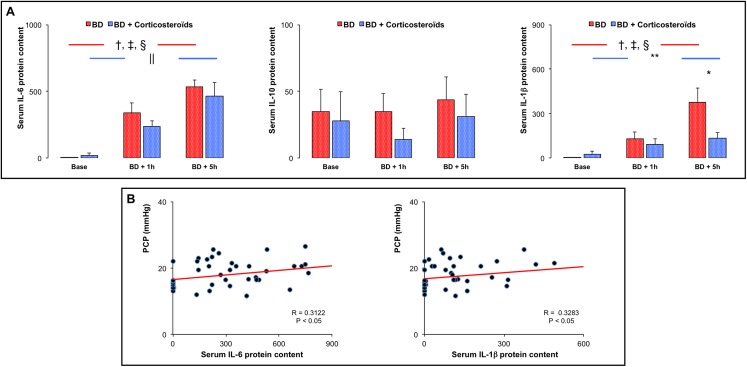
Serum interleukin (IL)-6, IL-10 and IL-1β protein concentrations.Panel A: Serum interleukin (IL)-6, IL-10 and IL-1β protein concentrations measurements at baseline, one (BD + 1 hour) and five (BD + 5 hours) hours after Cushing reflex in placebo-pretreated brain death (BD group; n = 11; red bars) and in the methylprednisolone-pretreated brain death (BD + Corticosteroids group; n = 8; blue bars) groups. Values are expressed as mean ± SEM. * p<0.05 BD versus BD + Corticosteroids; † p<0.05 Base versus BD + 1 hour, ‡ p<0.05 BD + 1 hour versus BD + 5 hours, § p<0.05 Base versus BD + 5 hours in the BD group; || p<0.05 Base versus BD + 1 hour, ** p<0.05 Base versus BD + 5 hours in the BD + Corticosteroids group. Panel B: Correlations between PCP and serum IL-6 and IL-1β.